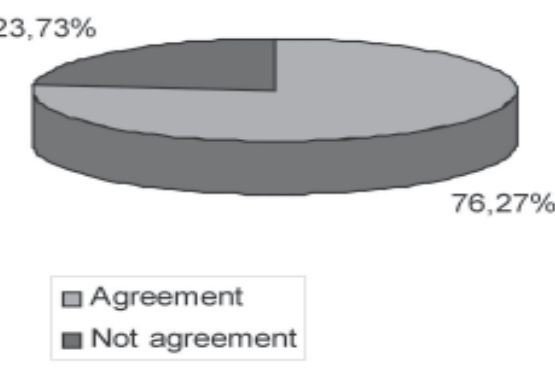
FIGURE 4- Percentage of agreements of diagnosis of inflammatory cyst after clinical radiographic versus